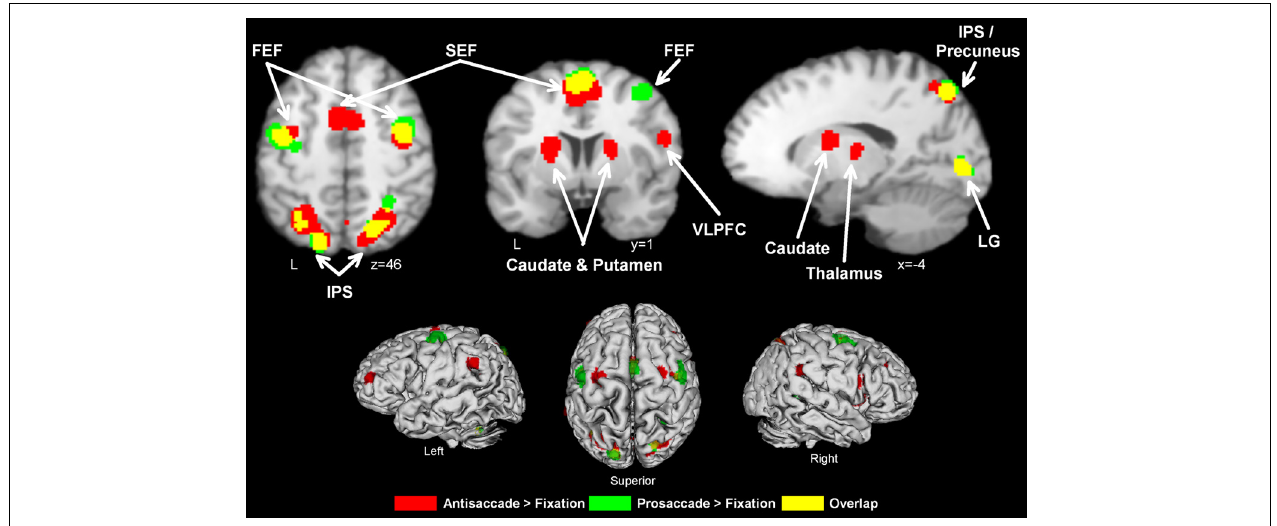
FIGURE 1 | Activation likelihood maps for antisaccade > fixation (red) and prosaccade > fixation (green). Regions where the contrasts overlap are shown in yellow. Abbreviations: FEF, frontal